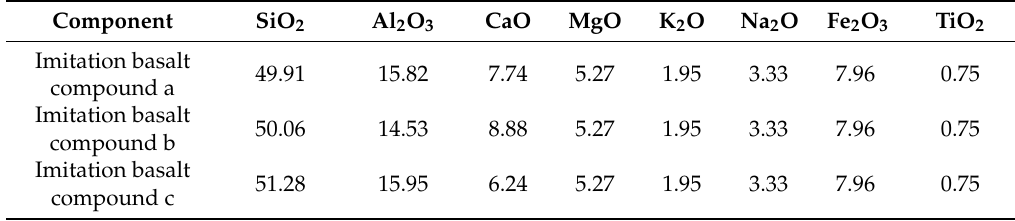
Figure 1. Ternary phase diagram of SiO 2 -Al 2 O 3 -CaO-Fe 2 O 3 -MgO-TiO 2 -O 2 . Table 2. Calculated chemical compositions of imitation basalt compounds (wt.%).